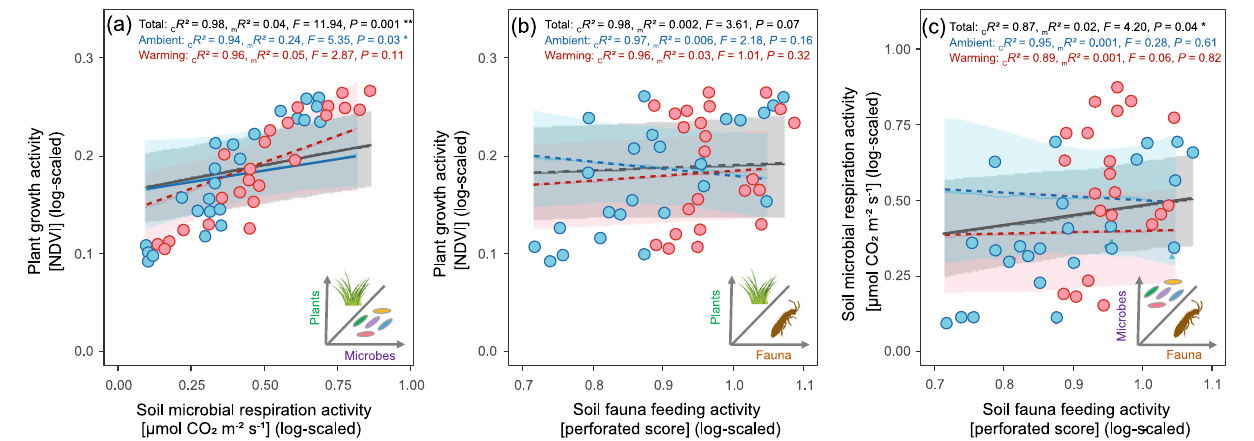
Fig. 4 | Relationships among activities of plants, soil microbes, and soil fauna. Correlations ( R 2 ) between plant growth activity and soil microbial respiration activity ( a ), between plant growth activity and soil fauna feeding activity ( b ), between soil microbial respiration activity and soil fauna feeding activity ( c ). The presented statistics are conditional R squares ( c R 2 ), marginal R squares ( m R 2 ), F - values, and p valuesfrom linear mixedeffects models.The statistical tests are two-